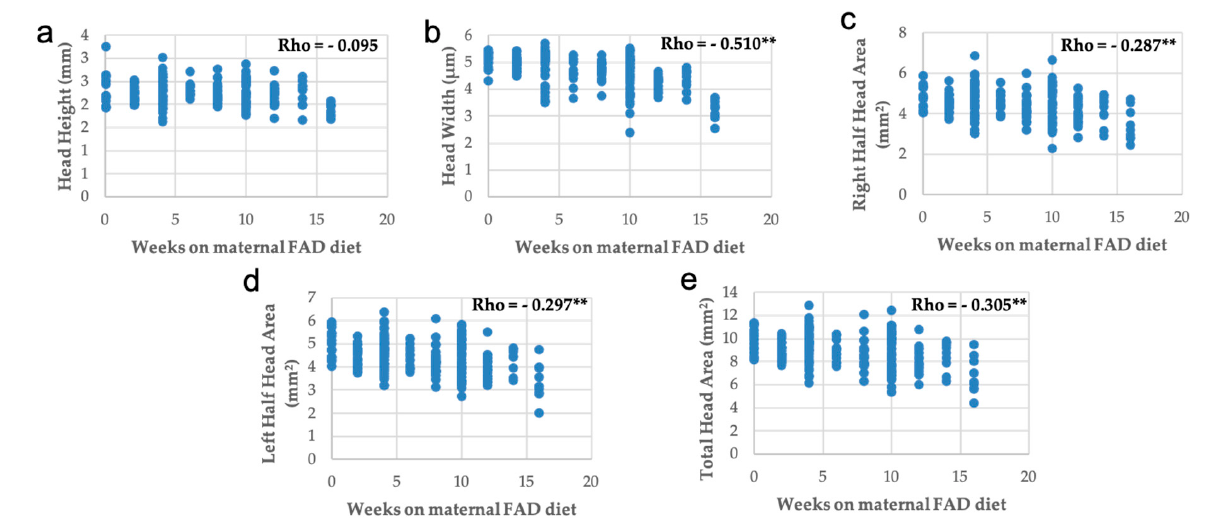
Figure 5. Correlations between head measurements with weeks on maternal FAD diet. ( a ) Head width; ( b ) head height; ( c ) right half head area; ( d ) left half head area and ( e ) total head area. ** p ≤ 0.01; Spearman’s Rho.